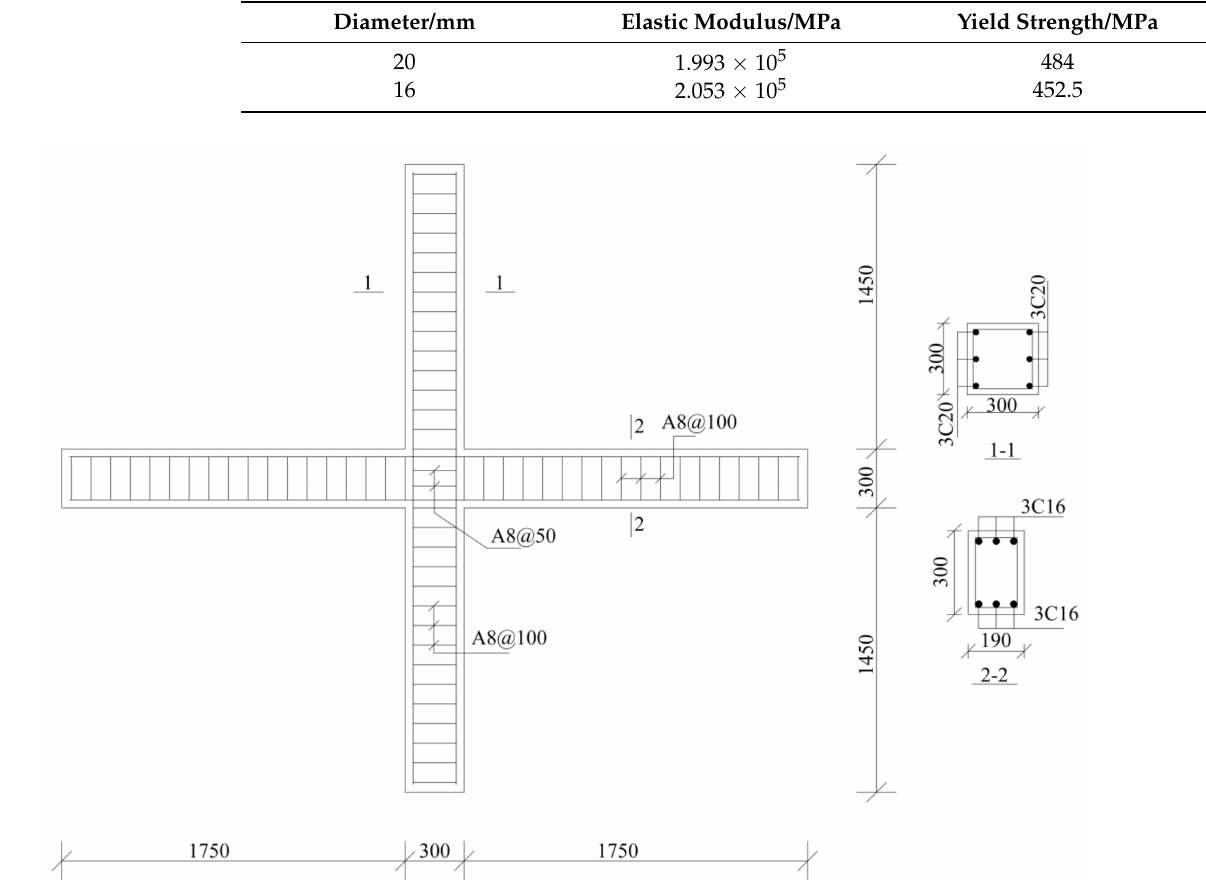
Figure 7. Dimensions and reinforcement of SAC beam-column joints. Displacement-controlled scheme was used to apply the vertical loading during the entire loading process. The amplitude of longitudinal displacement was 2 mm, 4 mm, 6 mm, 8 mm, 12 mm, 18 mm, 24 mm, and 36 mm for each cycle, respectively. Yield displacement was initially determined with yielding of the longitudinal reinforcements in beams. The amplitude of longitudinal displacement turned to integer multiple of yield displacement when the longitudinal reinforcements yielded. The vertical loading was gradually removed when the residual load-carrying capacity reduced to around 85% of the peak load-carrying